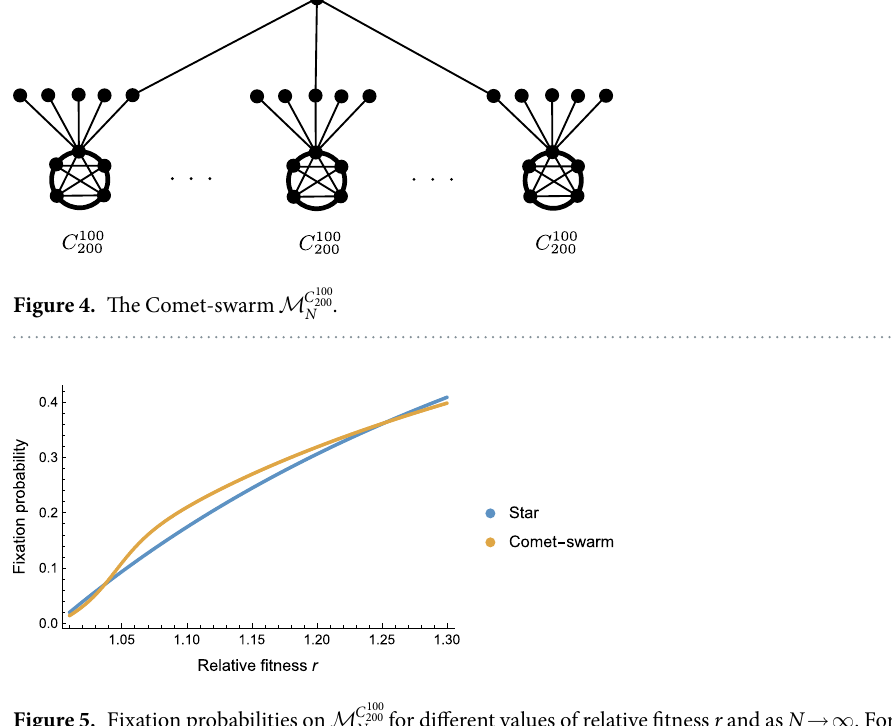
200100  Figure 5. Fixation probabilities on NC for different values of relative fitness r and as N → ∞ . For a range of values of r the Metastar amplifies more strongly than the